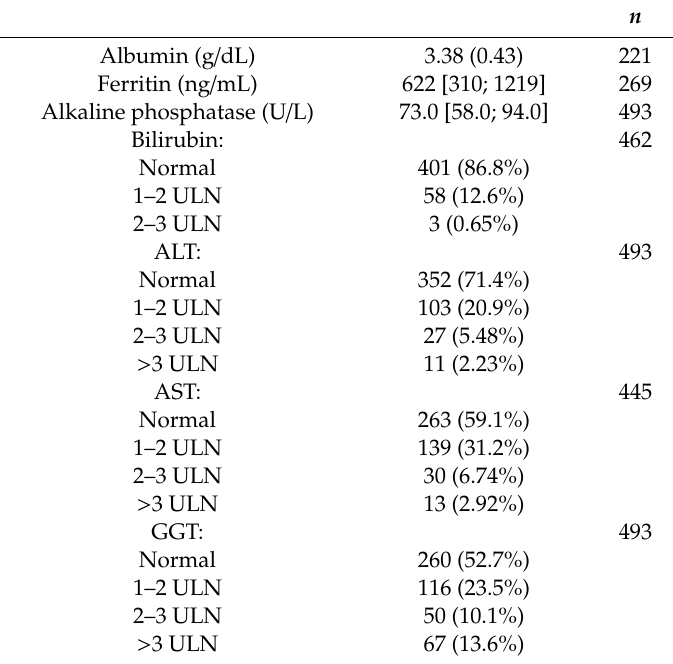
Table 2. Baseline liver